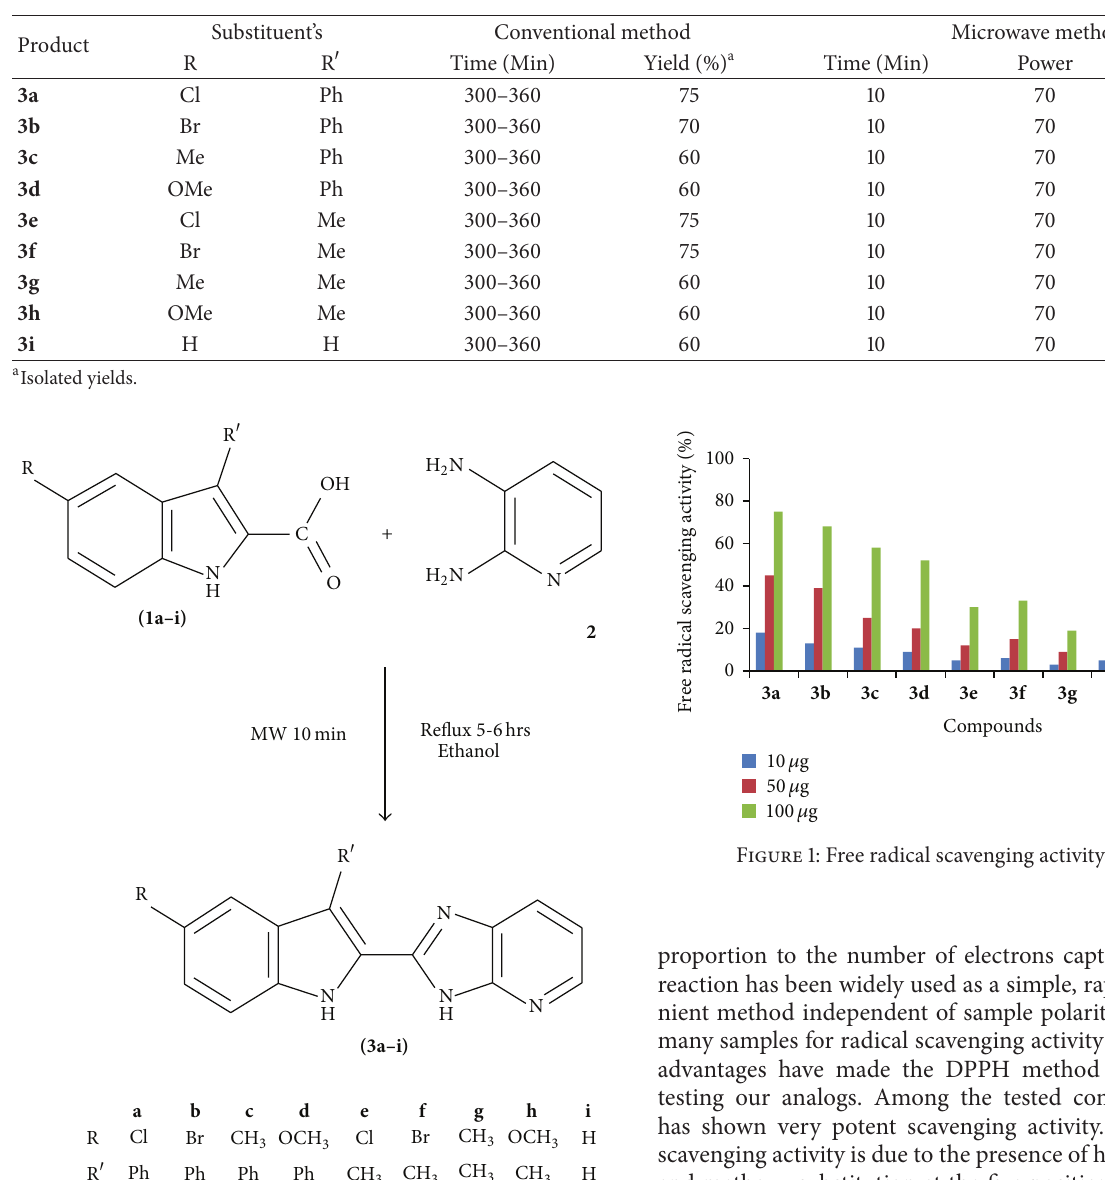
Table 1: Comparative data of conventional and microwave method for the imidazolopyridinyl indole analogues 3a–i .